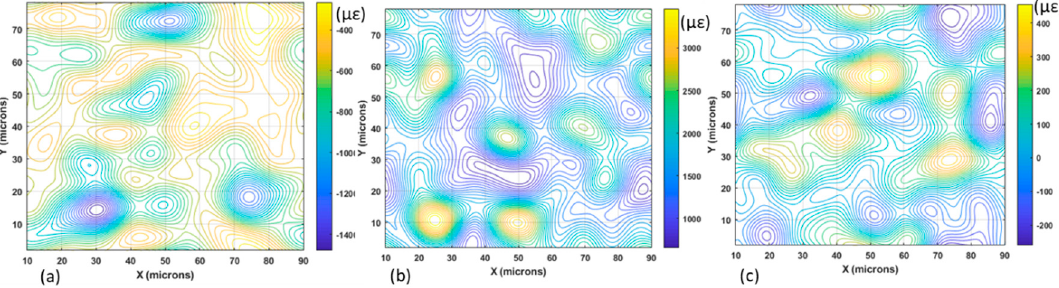
Figure 13. Components of the full Euler–Almansi strain tensor determined for the tensile Al–SiC composite specimen: ( a ) ε x E ; ( b ) ε y E ; and ( c ) ε xy E .